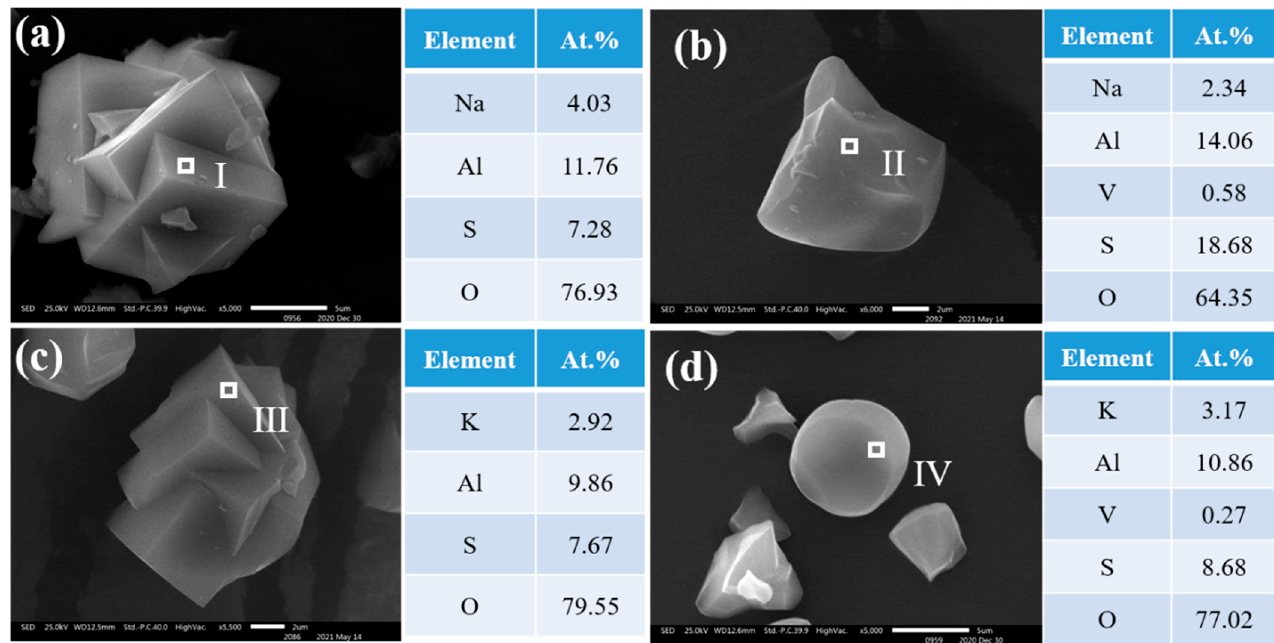
Figure 12. SEM-EDS patterns of samples obtained at pH value of 0.6: ( a ) Na:Al = 1:1; ( b ) Na:Al = 1:1; ( c ) K:Al = 1:1; ( d ) K:Al = 1:1.